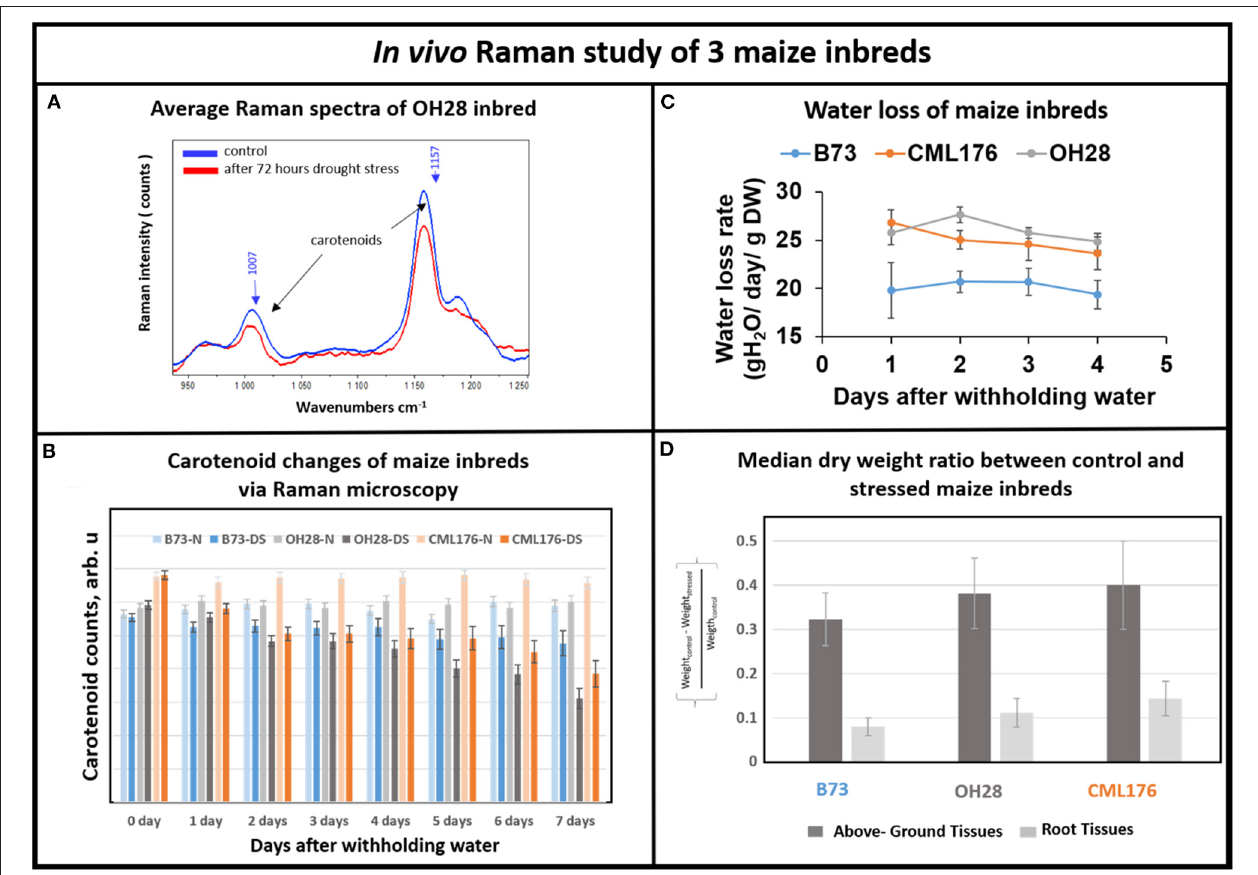
FIGURE 4 | (A) Average Raman spectra of OH28 inbred: control vs. 72h after drought stress. (B) Histogram of a change in the carotenoid content of plants at B73-N (control), B73-DS (drought stressed) CML176-N (control), CML176-DS (drought stressed), OH28-N (control) and OH28-DS (drought stressed). Each bar represents the mean + SE ( n = 3x5). (C) Transpirational water loss rate of the inbreds. (D) Histogram of dry weight ratio between the control and the stressed plants at B73, CML176, and OH28. The higher the value the more weight of tissue is lost and the more sensitive the plants are to drought